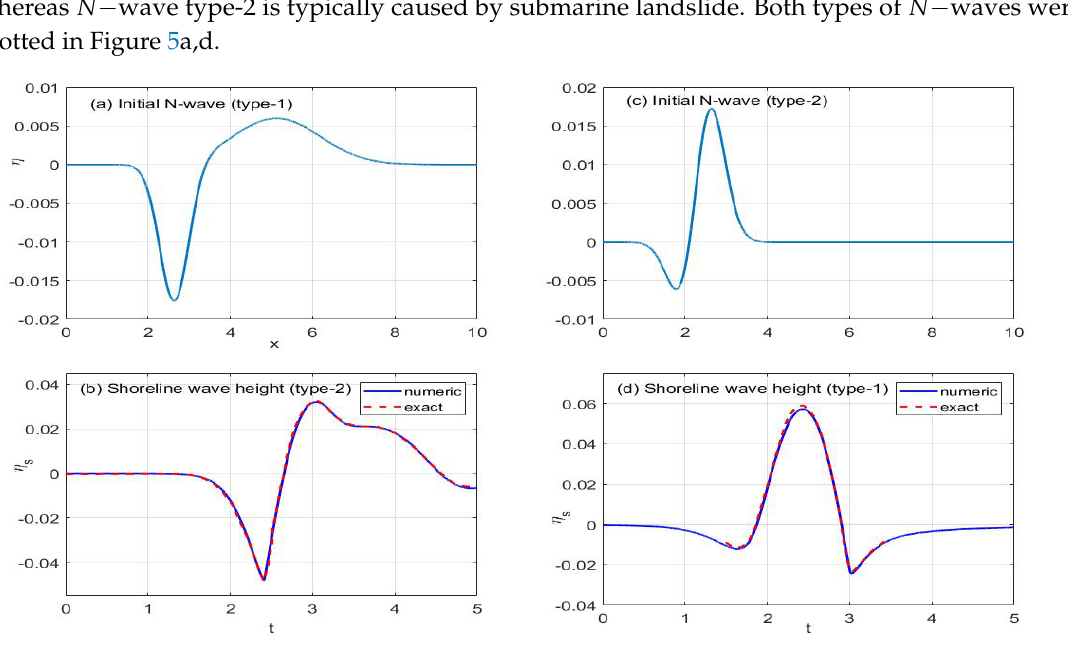
Figure 5. (Top left-right) The initial N-wave of type-1 and type-2, (bottom left-right) shoreline wave height of type-1 and type-2. The analytical shorelines are digitized from